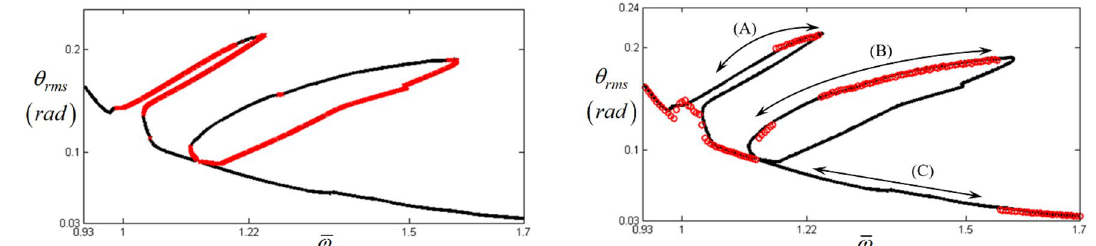
Figure 6. Nonlinear frequency response with RMS at sub-harmonic resonances: ( a ) HBM results with stability conditions; ( b ) comparison of HBM and NS results with various initial condition paths. Key: Balck line, HBM result with ε = 2.9 × 10 − 3 ; Red times, HBM results with the unstable condition; Red open circle, NS result.